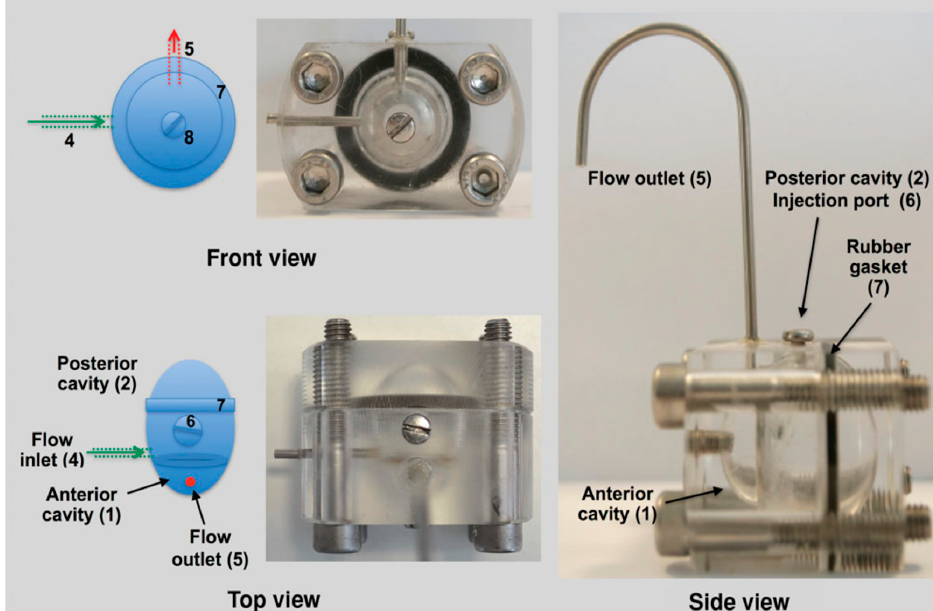
Figure 6. A two-compartment in vitro model of the eye (known as PK-Eye) used in study of the release profile of dexamethasone loaded PLGA microparticles. (Reprinted from Journal of Pharmaceutical Sciences , 104, Sahar Awwad, Alastair Lockwood, Steve Brocchini, Peng T. Khaw, The PK-Eye: A novel in vitro ocular flow model for use in preclinical drug development, 3330–3342, Copyright (2015), with permission from Elsevier